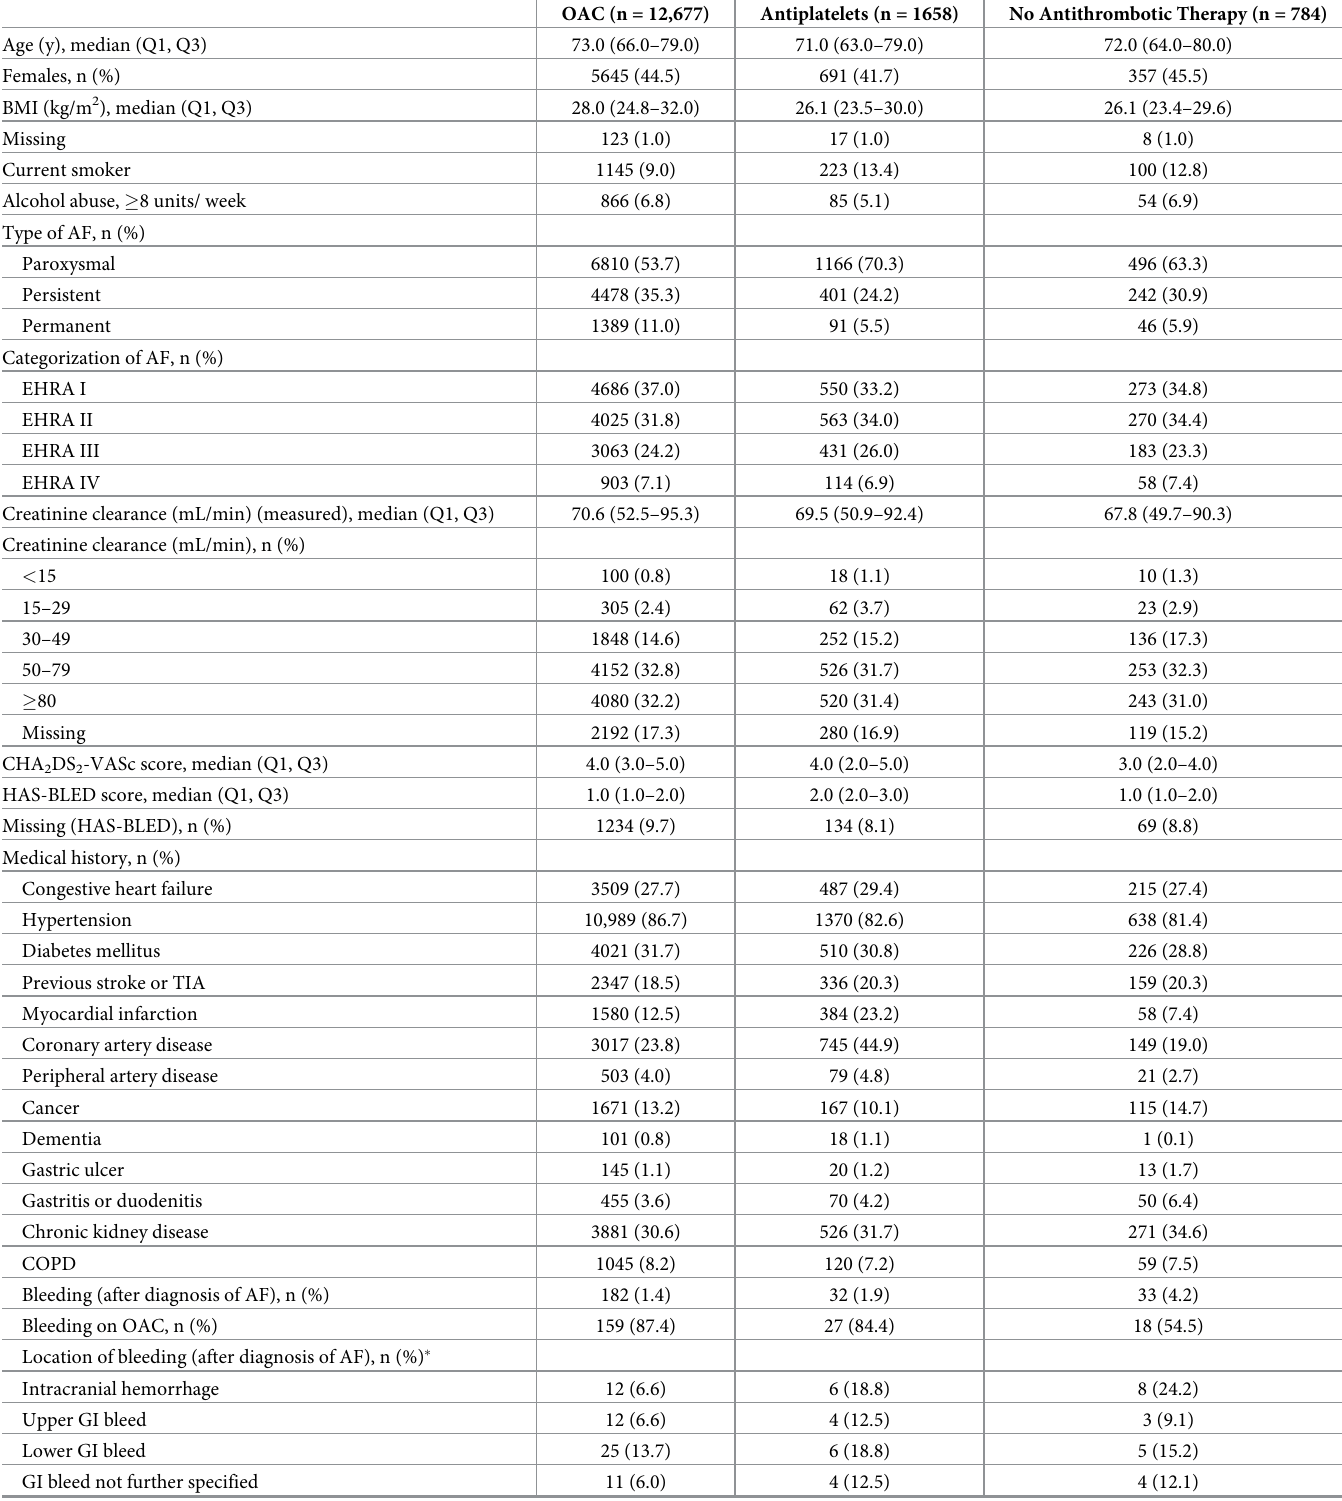
Table 2. Baseline characteristics of AF multimorbid patients prescribed OAC or antiplatelets or no antithrombotic therapy a